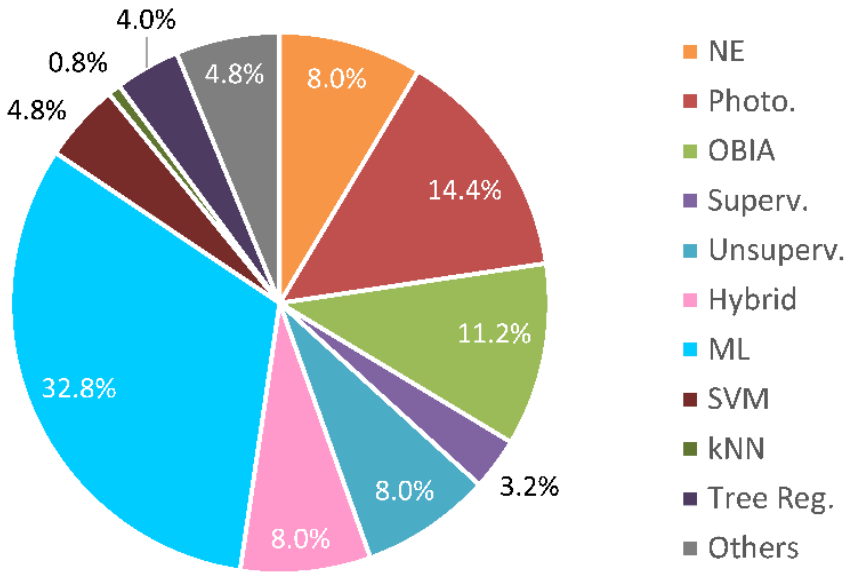
Figure 9. Methods used for obtaining LUC maps only including those developed with RS (128 papers). NE: not explained; Photo: photointerpretation of satellite images; OBIA: object-based image analysis; Superv: supervised classification, without more specifications; Unsuperv: unsupervised classification; Hybrid: hybrid classifier; ML: maximum likelihood; SVM: support vector machine;